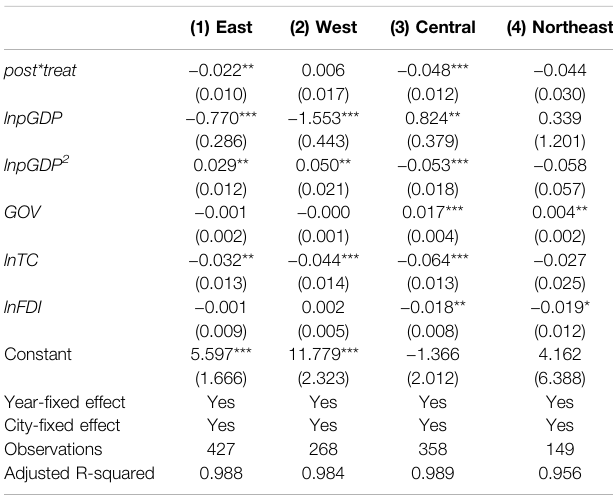
TABLE 4 | Heterogeneity effects of city